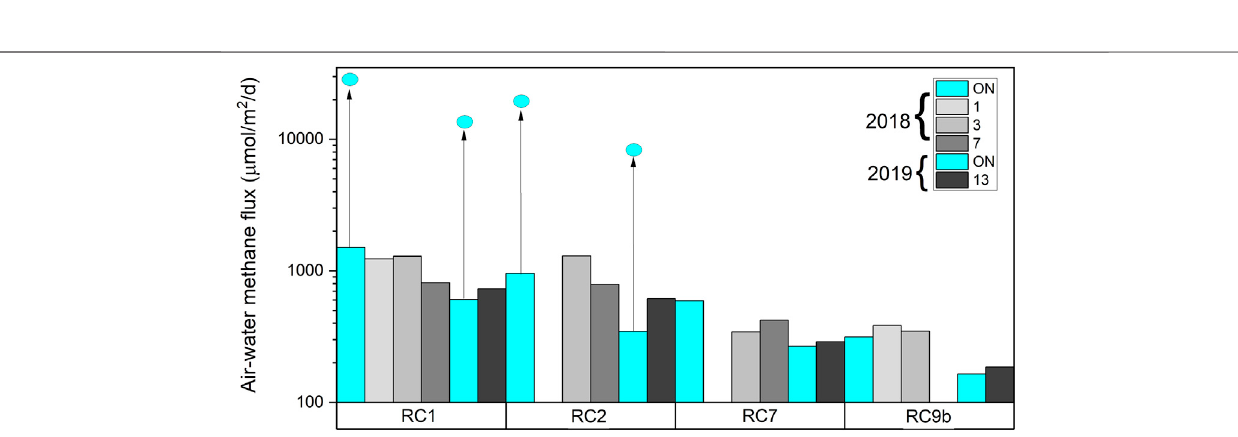
FIGURE 7 | Methane concentrations in air above the water in (A) 2018 and (B) 2019. δ 13 C-CH 4 values in air above the water in (C) 2018 and (D) 2019. Shaded regions indicates when aerators were OFF.